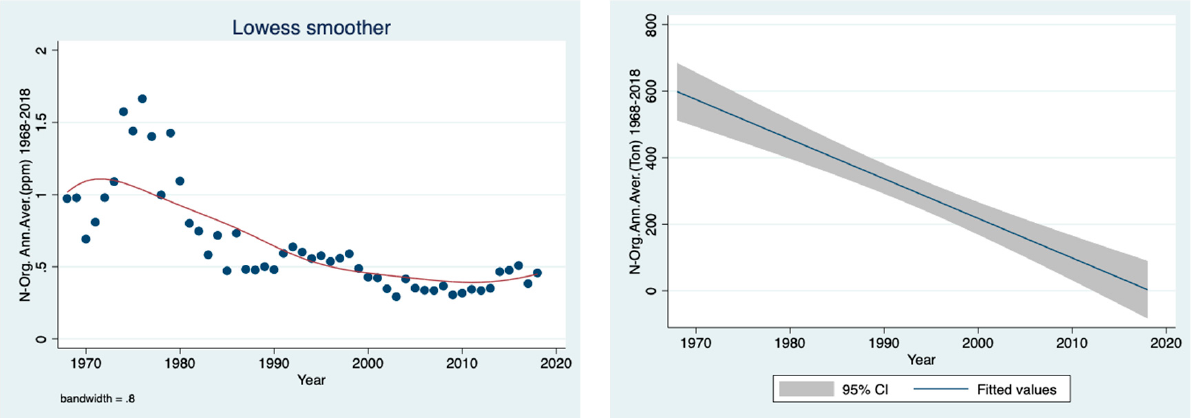
Figure 6. Linear prediction (95% CI) ( left ) and LOWESS smoother (0.8 bandwidth) trend of changes ( right ) between annual means of organic nitrogen concentration (ppm) in River Jordan waters (Huri Station) and years during 1968–2018.